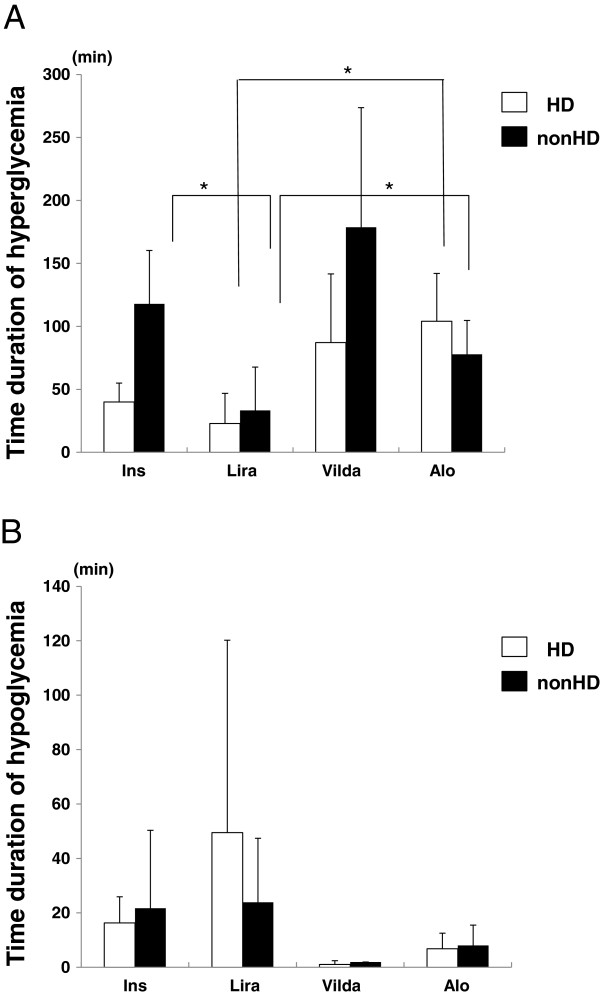
Duration of hyperglycemia (A) and hypoglycemia (B). Data are presented as mean ± SEM, *p < 0.05, n = 10, Ins; insulin, Lira; once-daily injection of 0.3 mg liraglutide, Vilda; once-daily oral administration of 50 mg vildagliptin, Alo; once-daily oral administration of 6.25 mg alogliptin.